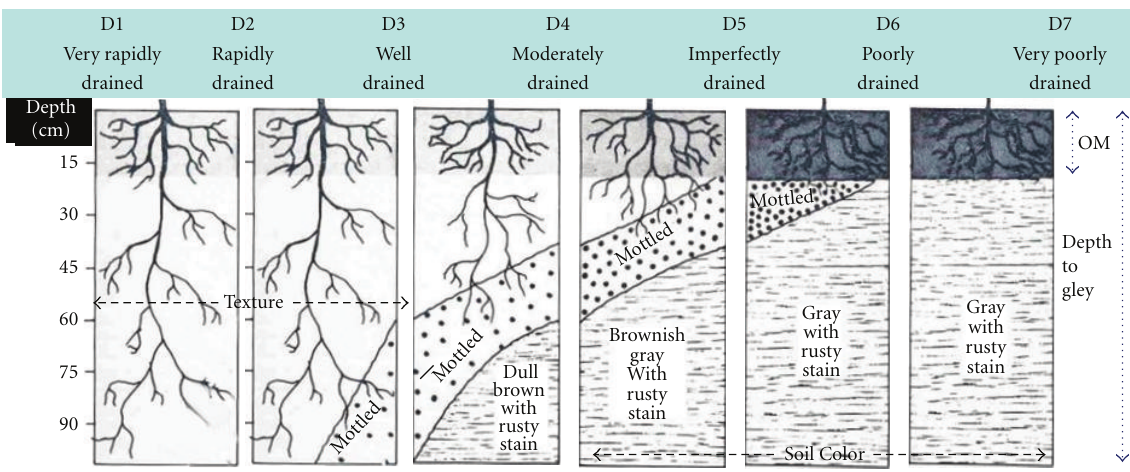
Figure 2: Soil drainage classes identified by soil survey experts in the Bras d’Henri watershed. D3: well drained; D4: moderately well drained; D5: imperfectly drained; D6: poorly drained; D7: very poorly drained.